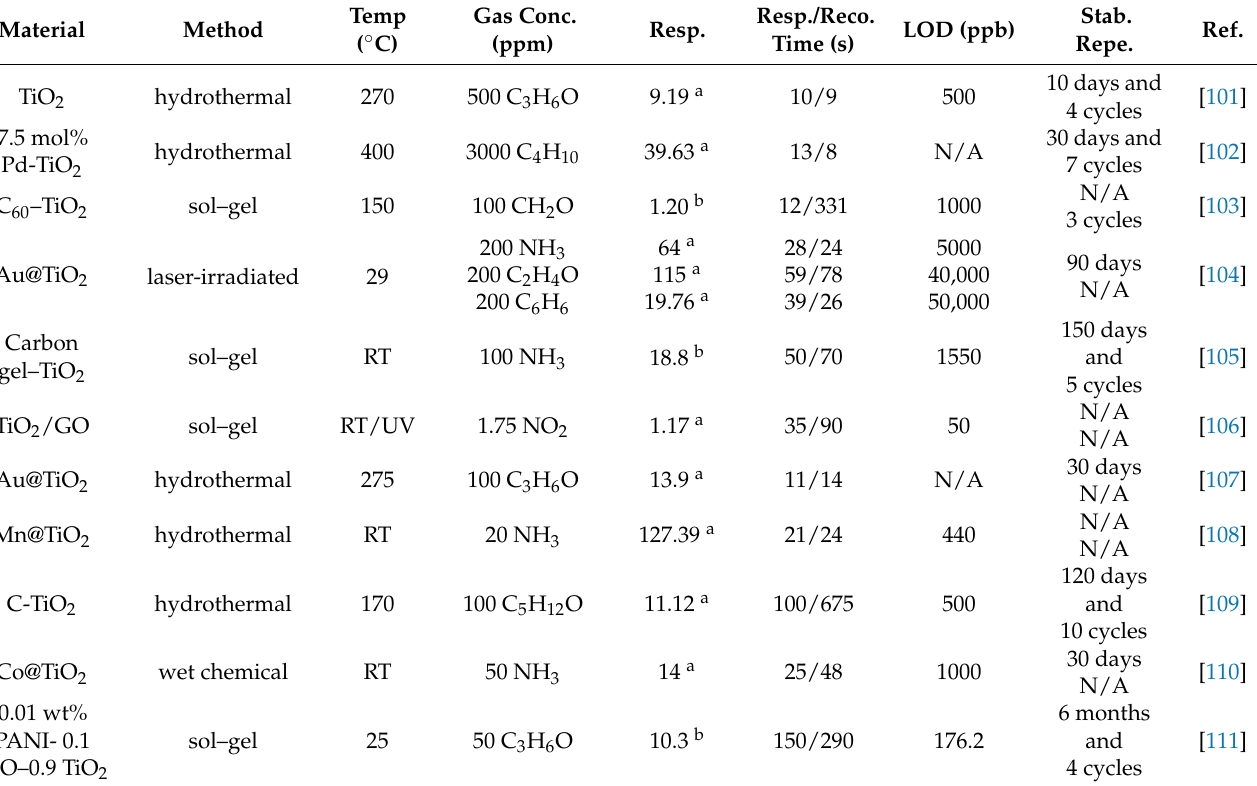
Table 4. Gas-sensing functionality of 0D TiO 2